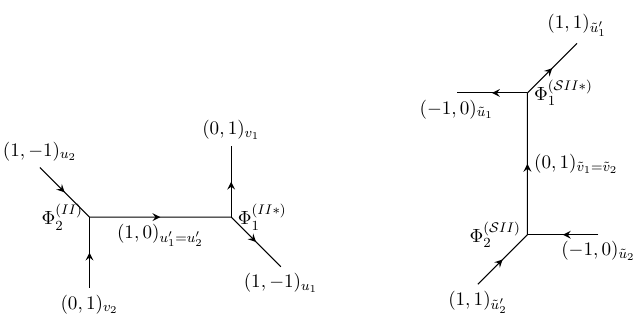
Figure 4 . Representation of the S-dual Lax matrices obtained as (cid:8) ( II (cid:3) ) (cid:8) ( II ) and (cid:8) ( S II (cid:3) ) (cid:1) (cid:8) ( S II ) . Changing the preferred direction e(cid:11)ectively rotates the brane-web, although there is an important di(cid:11)erence between their computation and ours: in our case, topological vertices are also rotated, which requires the use of a di(cid:11)erent